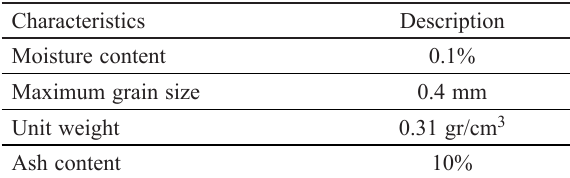
Table 5. Characteristics of Crumb Rubber used in this study Characteristics